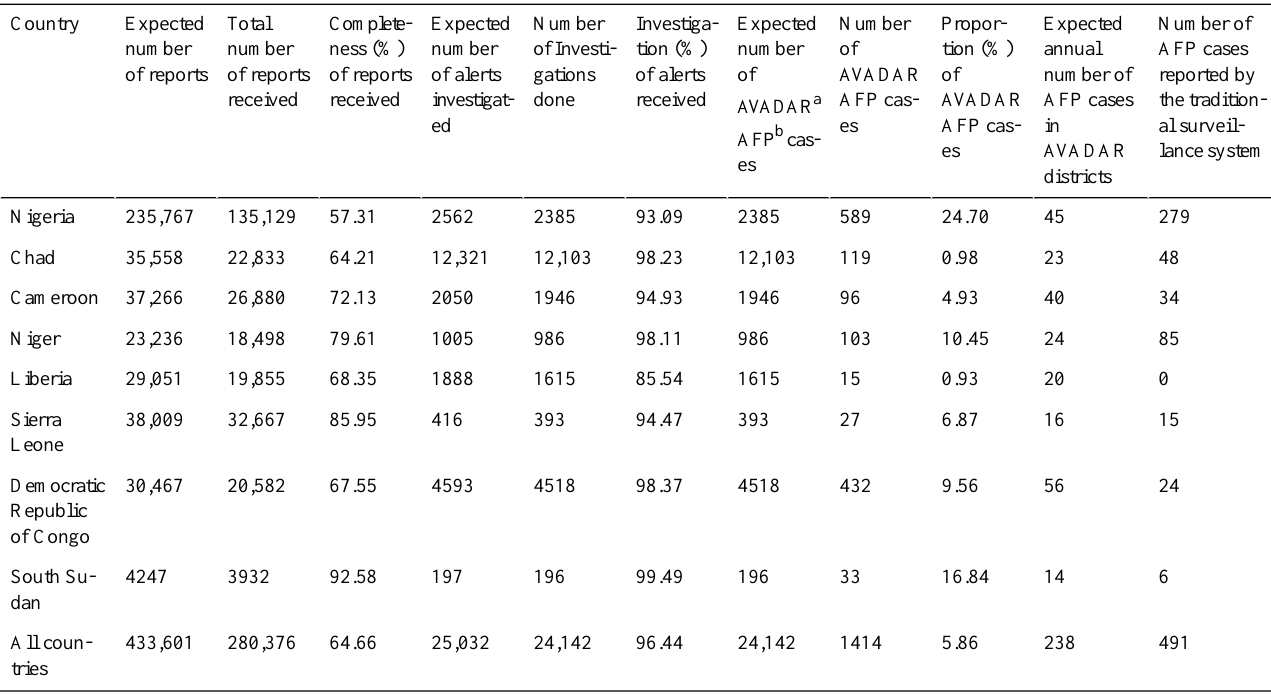
Table 2. Performance of the Auto-Visual Acute Flaccid Paralysis Detection and Reporting (AVADAR) system compared with the traditional system of reporting acute flaccid paralysis cases from August 1, 2017, to July 31, 2018.